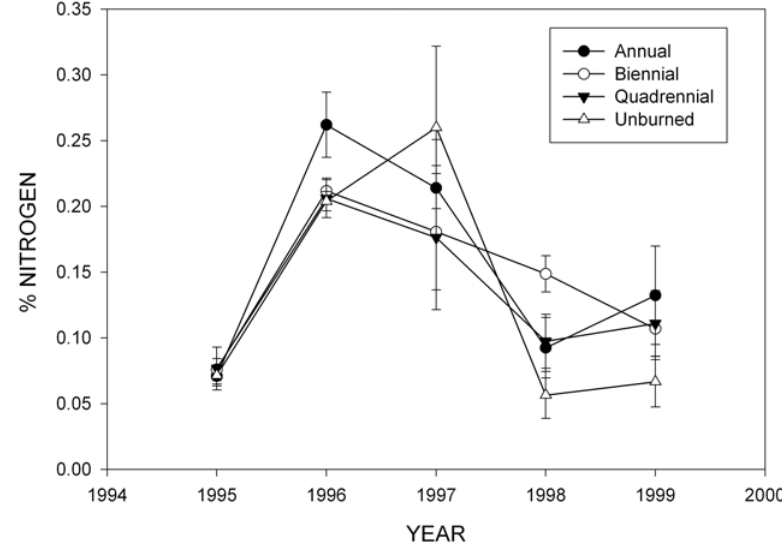
Figure 2. Mean percent nitrogen in longleaf pine logs placed on plots receiving dormant season prescribed burns at different frequencies over 40 years on the Osceola National Forest, Baker County,